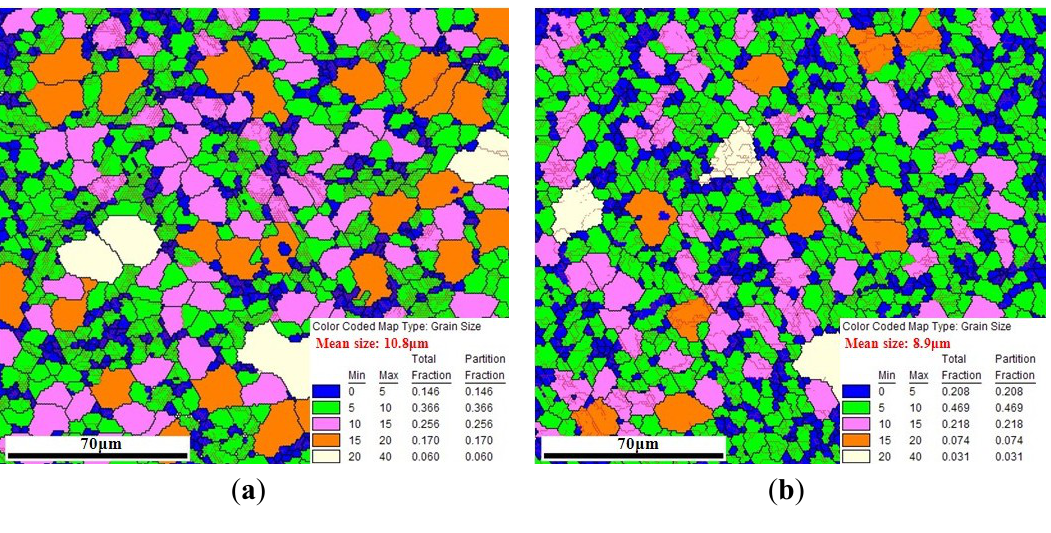
Figure 14. ( a ) Cross-sectional EBSD result of as-received tube; ( b ) cross-sectional